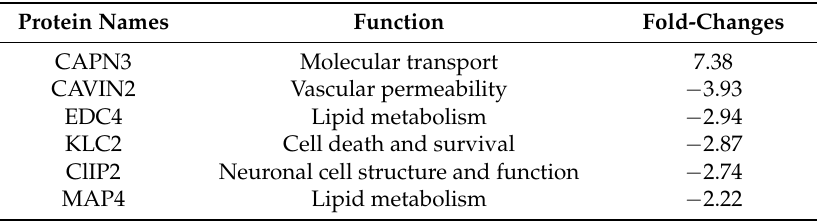
Table 3 . Differentially expressed proteins identified by IPA in the ocular tissue in response to µg vs. µg + 1 g (fold change >2, FDR corrected p < 0.05).